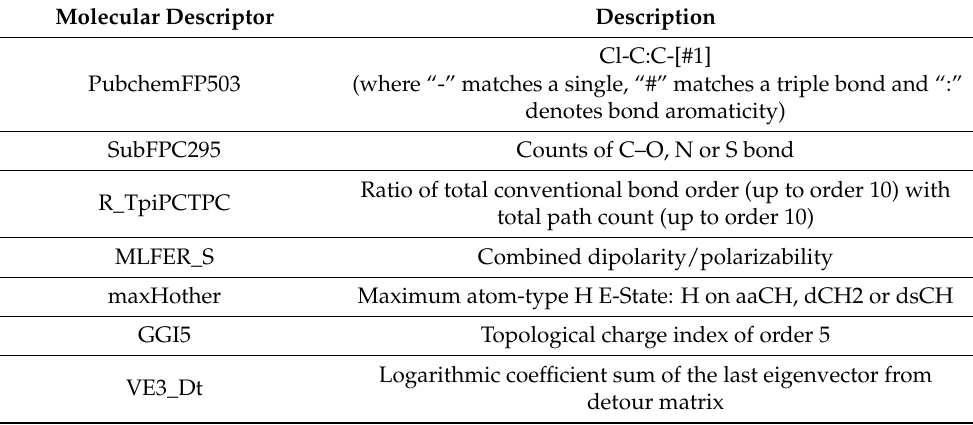
Figure 4. Plot of experimental vs. predicted Log BMF L values of the proposed MLR-OLS model based on Dataset 3 (Equation (3)). Black dots = training set. White dots = prediction set. Table 4. List of the molecular descriptors included in Equation (3) and short